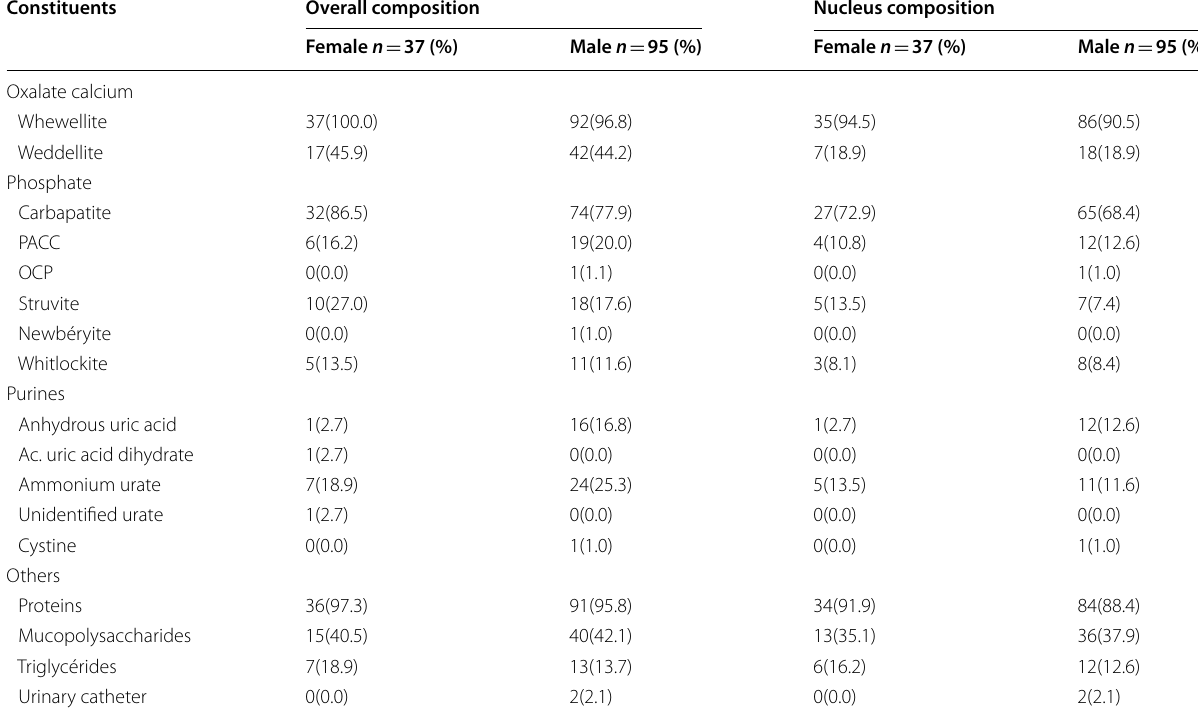
PACC: Amorphous carbonate calcium phosphate; OCP: octocalcium phosphate